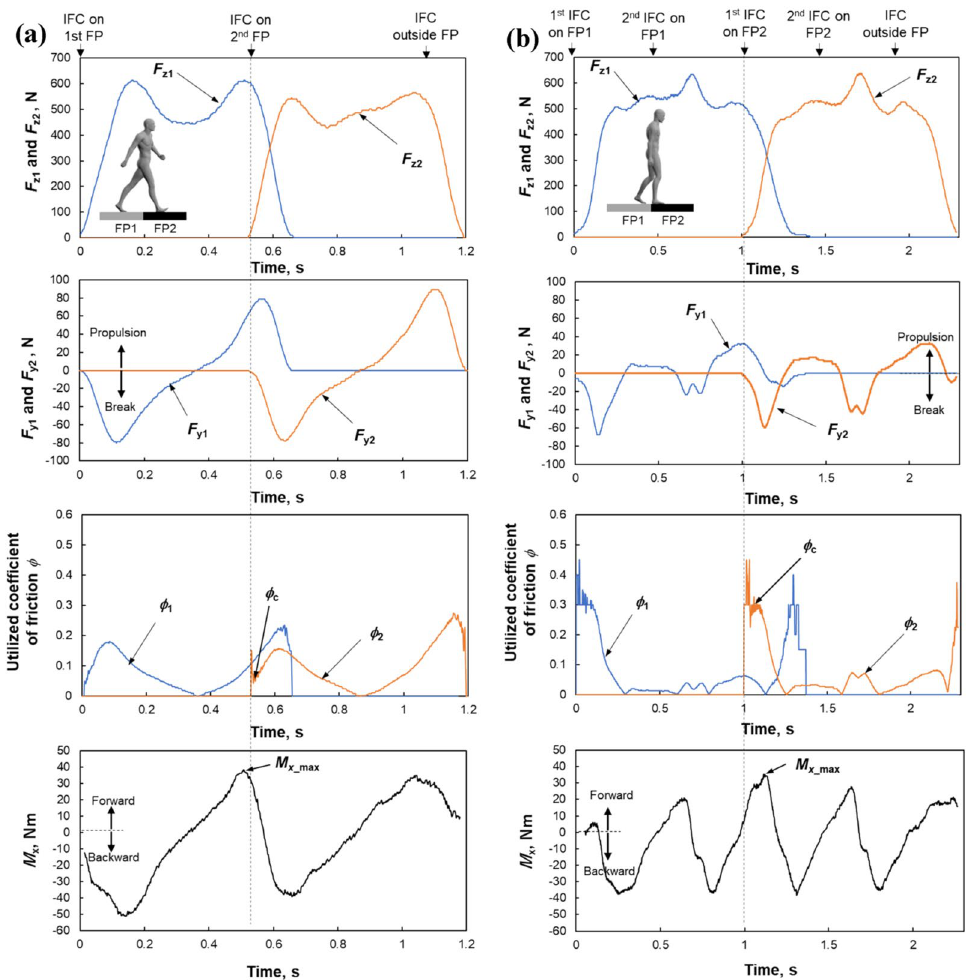
Figure 5. Example of the temporal change for a single subject in the vertical GRFs ( Fz 1 and Fz 2 ), anterior– posterior GRFs ( F y 1 and F y 2 ), the utilized coefficient of friction ( 1 and 2 ), and the external moment about COM ( M x ) during the normal ( a ) and shuffling gait ( b ) under low-friction conditions. M x_max is the maximum ϕ ϕ external forward moment about COM. c is the utilized coefficient of friction at the timing when the F z2 was > 50 N. Initial foot contact (IFC) timing for each step except the first step on the first and second force plates ϕ (FPs) were indicated with